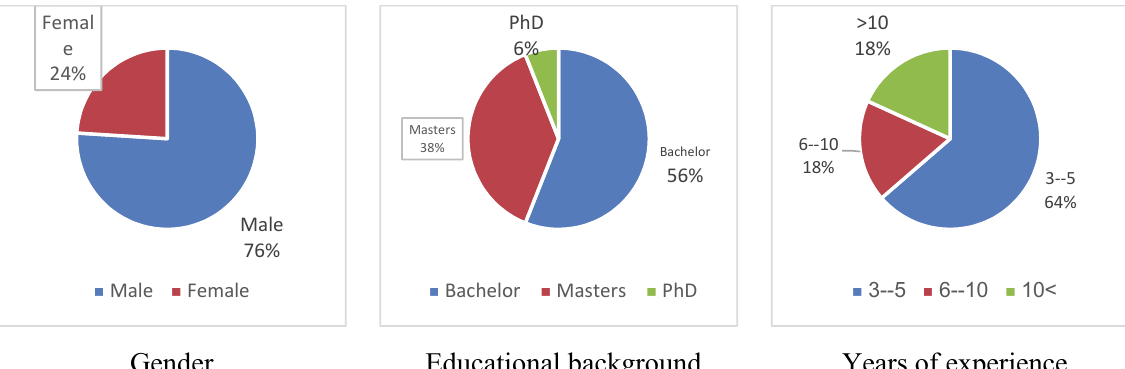
Fig. 1. Personal characteristics of the participants